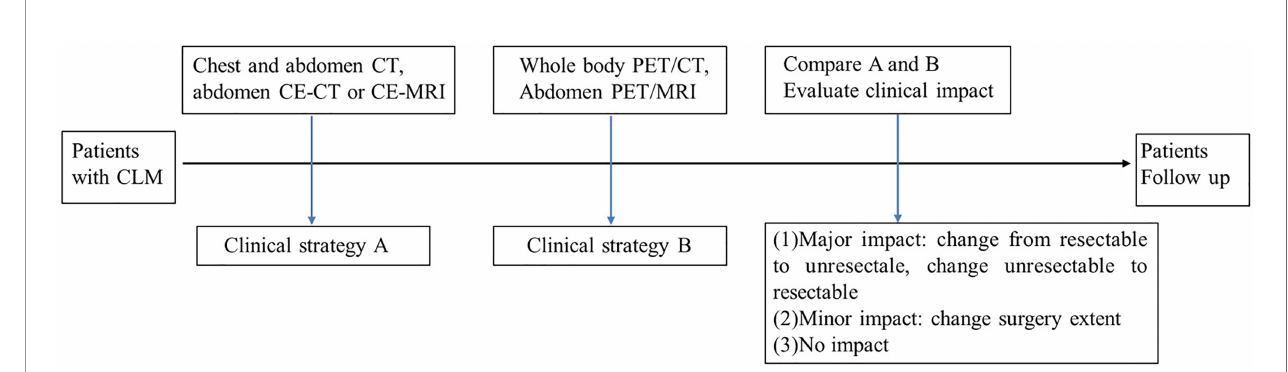
FIGURE 2 | The analysis fl ow chart of clinical